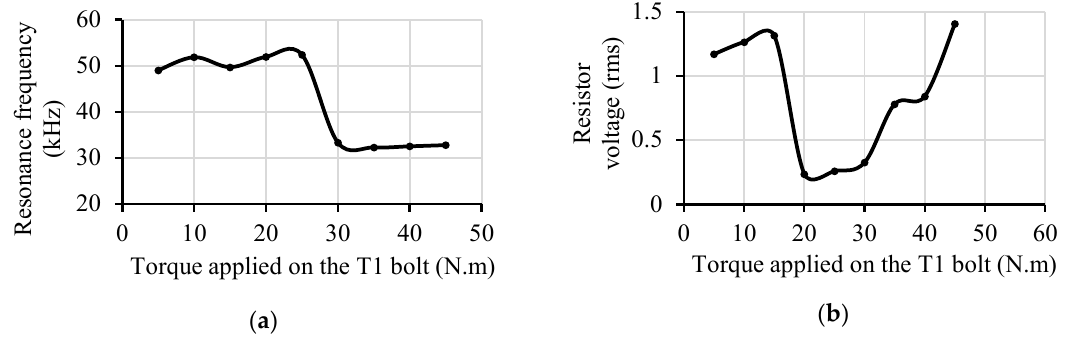
Figure 10. Effect of the applied torque on the bolt over; ( a ) The resonance frequency; and ( b ) The resistor voltage for transducer T1.